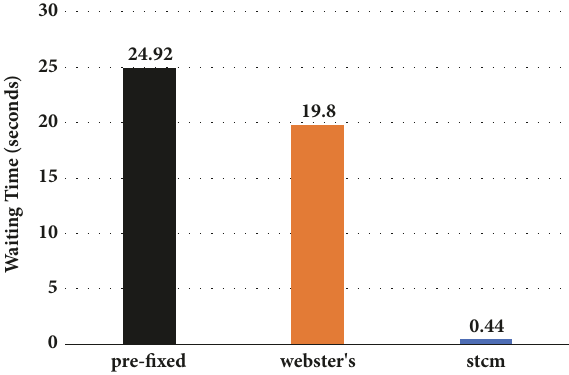
Figure 7: Emergency vehicles waiting